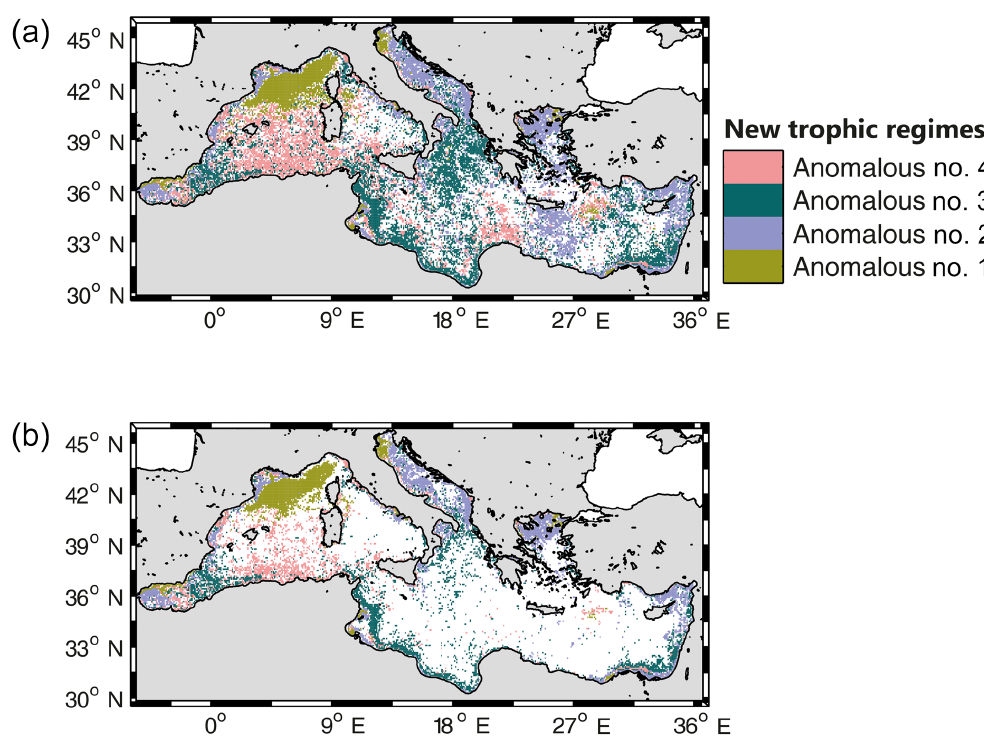
Figure 6. (a) Map of the most recurrent bioregions, calculated only for the “Anomalous” bioregions. (b) As in the Fig. 6a, but only the pixels that had at least their most recurrent bioregion for 2years are